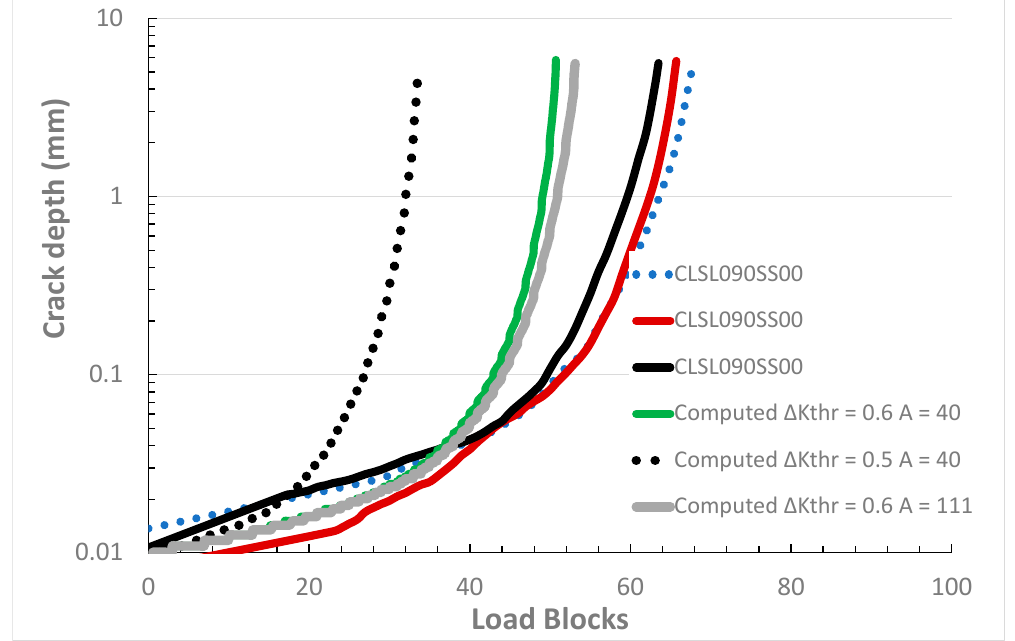
Figure 9. The measured and computed crack depth histories for the helicopter flight load spectrum CLS0900SS00.